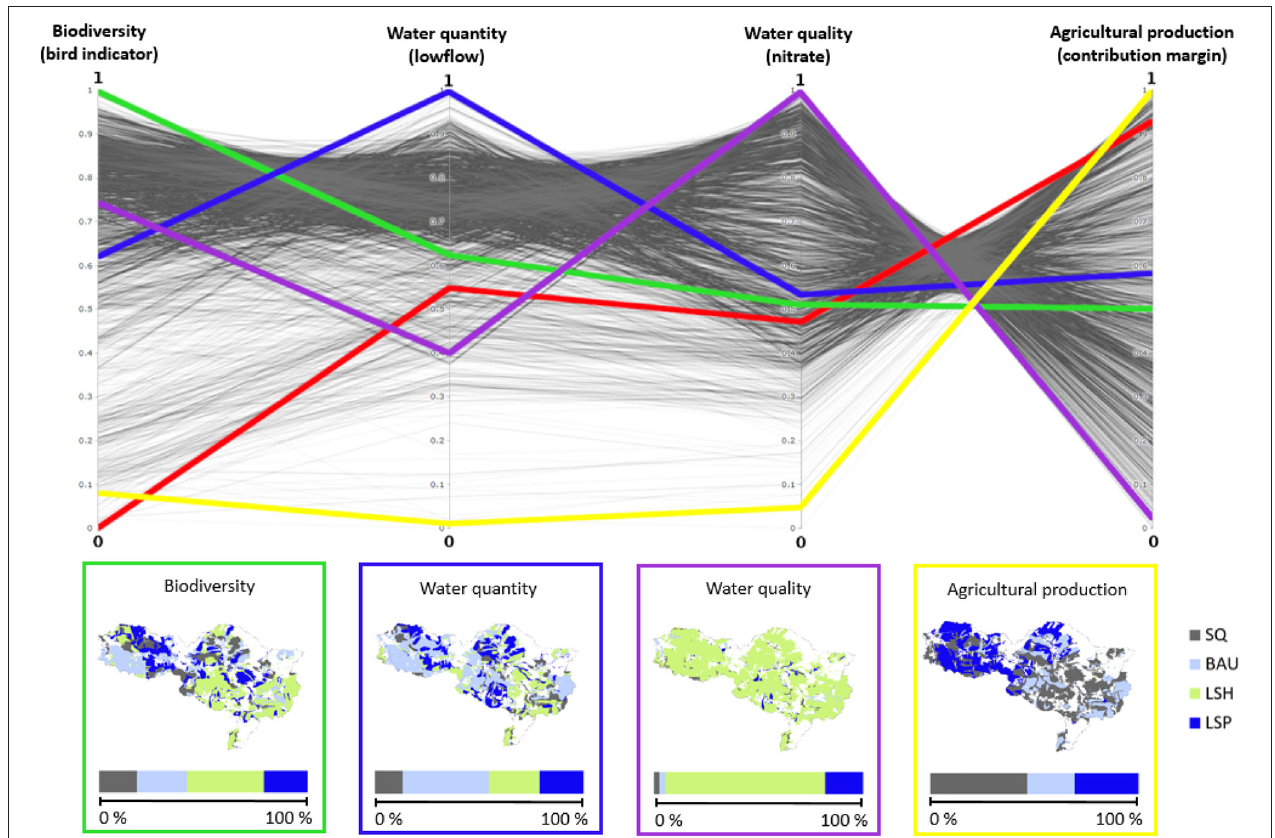
FIGURE 4 | Parallel coordinates plot of the Pareto-optimal solutions. The solutions with the best performance for each objective (extreme solutions) are marked in yellow (contribution margin), green (biodiversity), blue (water quantity), and purple (water quality), the red line corresponds to the status quo. The respective spatial distribution and the percental share of the land management scenarios are shown in the boxes below the plot.